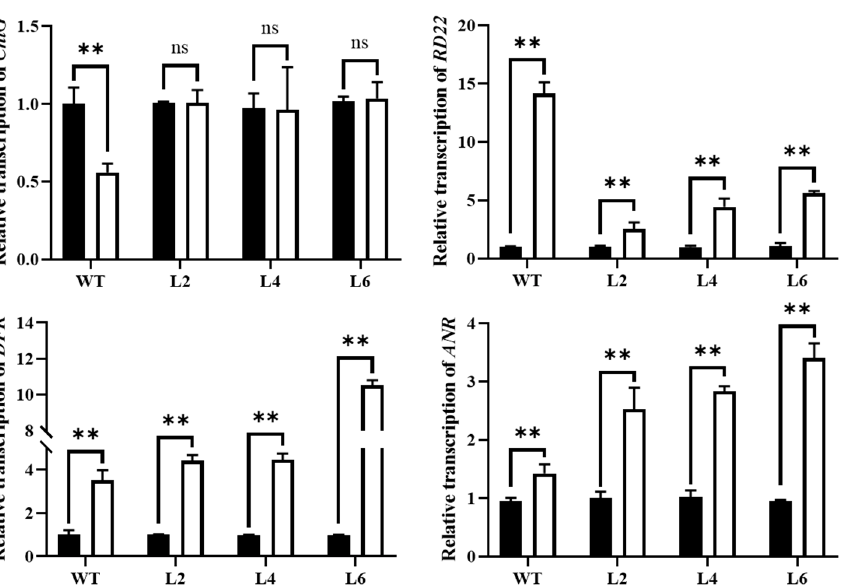
Figure 10. Relative transcriptions of ChlG , DFR , ANR , and RF22 genes of TaPsb28 -overexpressing Arabidopsis seedlings in response to drought stress. The black column represents the plants treated by normal watering, while the white column represents the plants subjected to drought stress by withholding irrigation for 14 days. Data are expressed as the means ± SDs ( n = 3). “**” indicates statistically significant differences between the CK and drought treatments at p < 0.01, while “ns” represents nonsignificant differences between the two treatments at the level of p < 0.05.